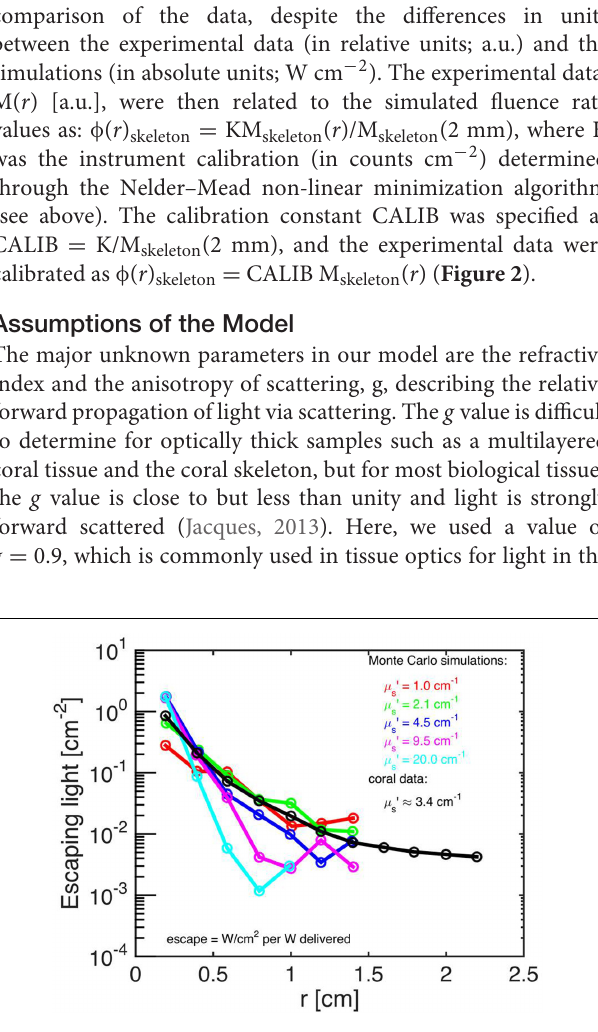
FIGURE 2 | Monte Carlo simulations to estimate coral skeletal optical properties. Escaping light [ φ ; W/cm − 2 per W delivered] as a function of radial distance (r) from the incident laser beam, as measured along the bare skeleton surface. Monte Carlo simulations were run for the 5 µ s ’ values (colored numbers) and for a constant µ a = 0.01 cm − 1 . The best fit of the experimental data (black) was µ s ’ = 3.4 cm − 1 ( n = 15 repetitions).